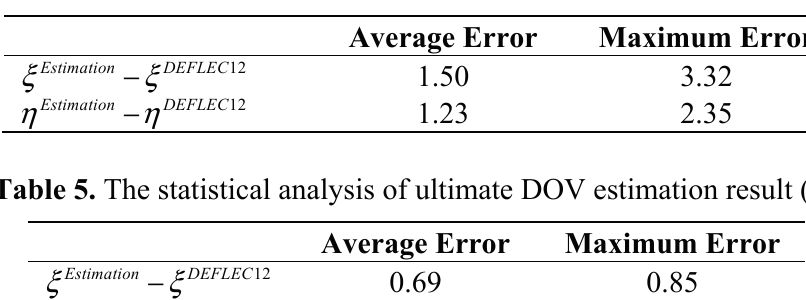
Table 4. The statistical analysis of preliminary DOV estimation result ( ″ ).